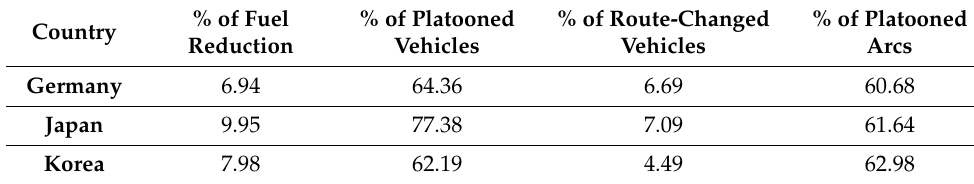
Table 6. Performance by country.